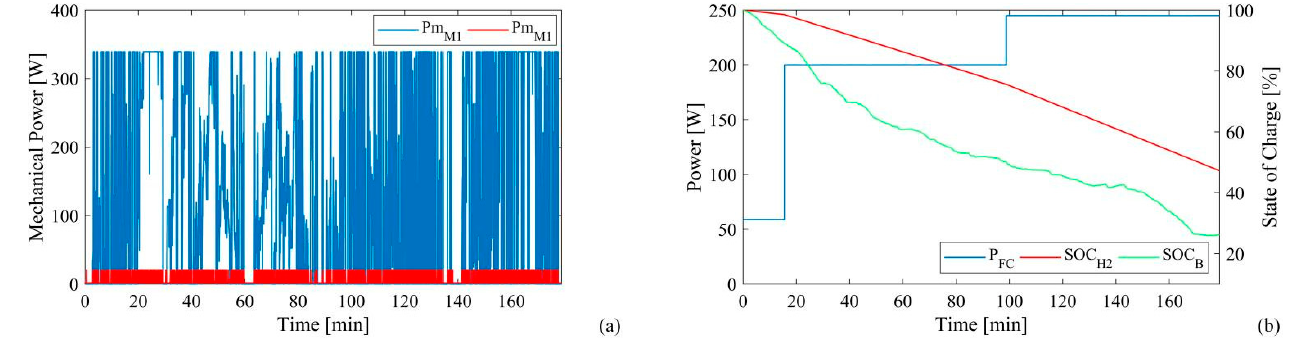
Figure 13. AMV performance in Journey 4, with control system correction: ( a ) Motor mechanical power trends; ( b ) Fuel cell power, hydrogen tank and battery state of charge trends.